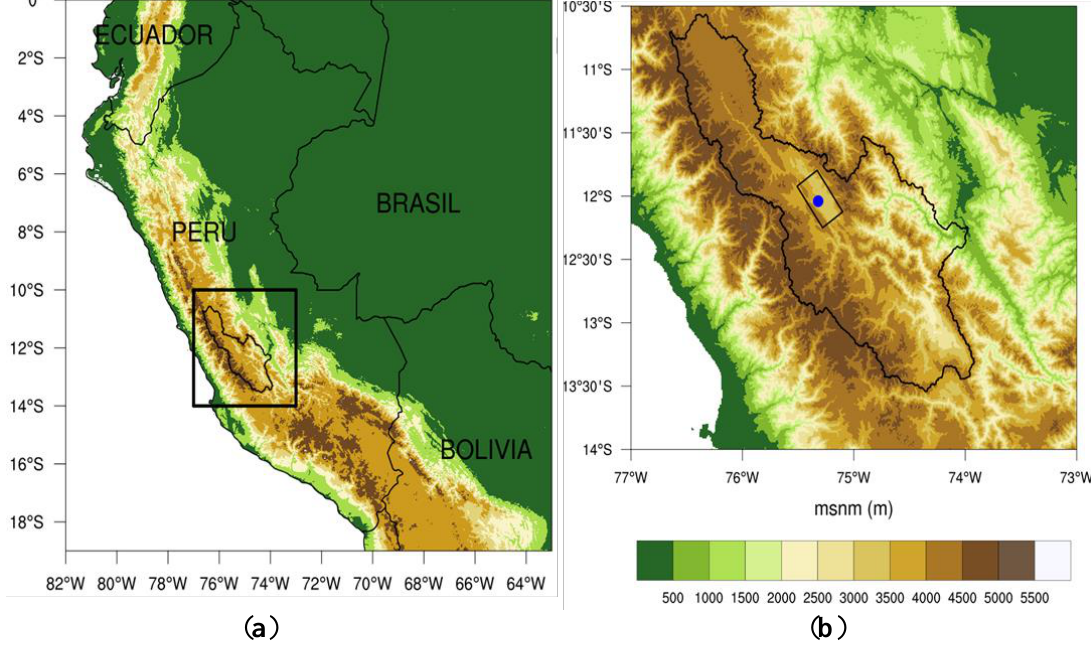
Figure 1. Study area, in ( a ) it shows Peru map and neighbor countries, in ( b ) it is Mantaro basin and inside the box is the Parsivel2 (Blue color). The contour indicates the topography values that are in meters and as reference is meter over sea level.